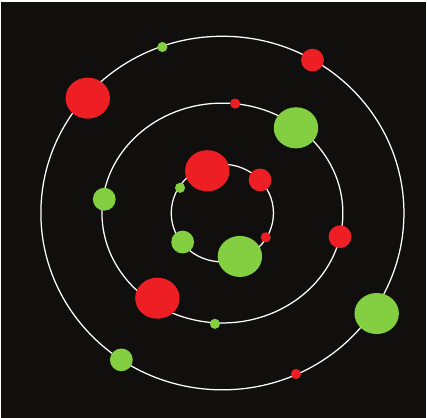
Figure 8: (This is not drawn to scale.) Reciprocal target acquisition task: users start by clicking the green target that appears at a random size and location on any of the rings. When the green target is clicked, the red target appears reciprocally to the green target. The measurements begin when the green target is clicked and end when the red target is clicked.